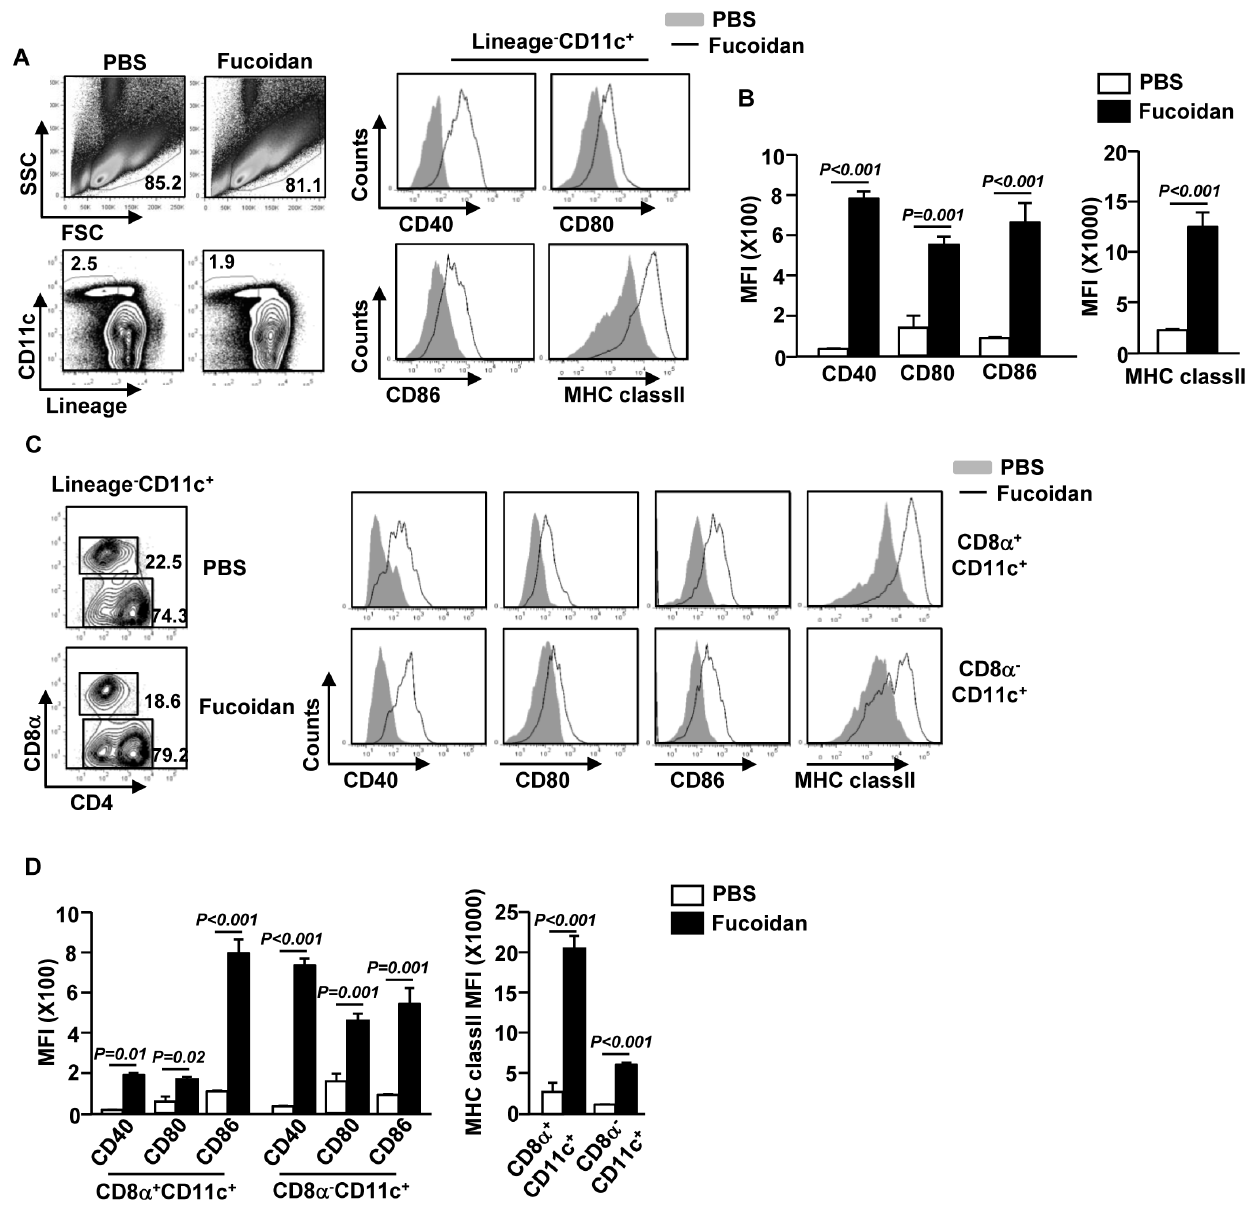
Figure 1. Invivo administration of fucoidan induces spleen cDC maturation. C57BL/6 mice were treated with 10 mg/kg fucoidan for 24 hrs. (A) Flow cytometric analysis of CD40, CD80, CD86 and MHC class II expression on the gated lineage 2 CD11c + cDCs in splenocytes (upper panels). Lineage markers included CD3, Thy1.1, B220, Gr1, CD49b and TER-119. (B) Mean fluorescence intensity (MFI) of CD40, CD80, CD86 (left panel) and MHC class II (right panel) was shown. (C) Lineage 2 CD11c + cDCs were further divided into CD8 a + and CD8 a 2 cDCs. Expression of CD40, CD80, CD86 and MHC class II was shown by histogram. (D) MFI of CD40, CD80, CD86 (right panel) and MHC class II (left panel) on CD8 a + and CD8 a 2 cDCs was shown. All data are representative of or the average of analyses of 6 independent samples (2 mice per experiment, total 3 independent